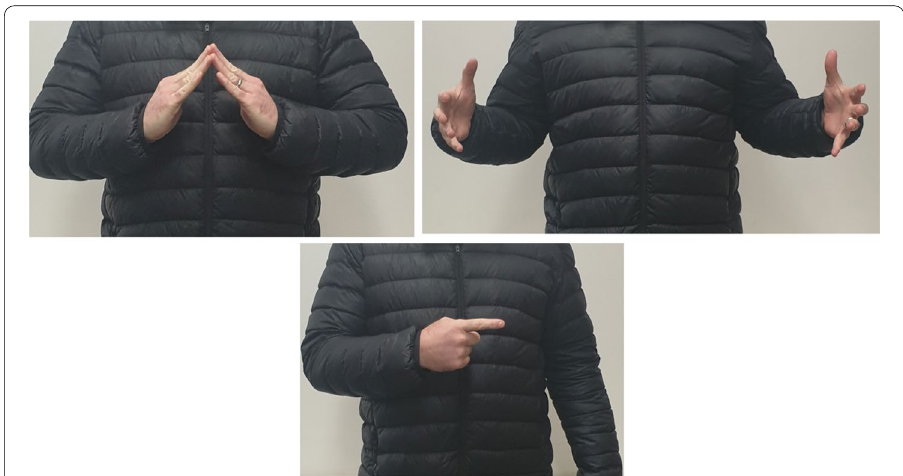
Fig. 1 Examples of representational gestures. Top left: Iconic gesture representing mountain . Top right: Metaphoric gestures conceptualizing the idea of large . Bottom: The use of a deictic gesture to direct spatial